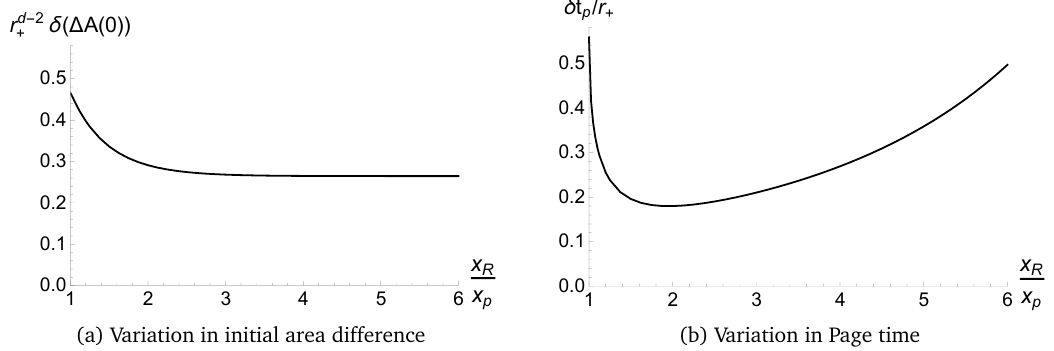
Figure 11: The variations in the (a) initial area difference and the (b) Page time as functions of the radiation region. We compute these quantities up to x which point our numerics become too noisy to be taken as reliable. Nonetheless, even within this range the numerics indicate that the variation in initial area difference monotonically falls while the variation in the Page time drops then